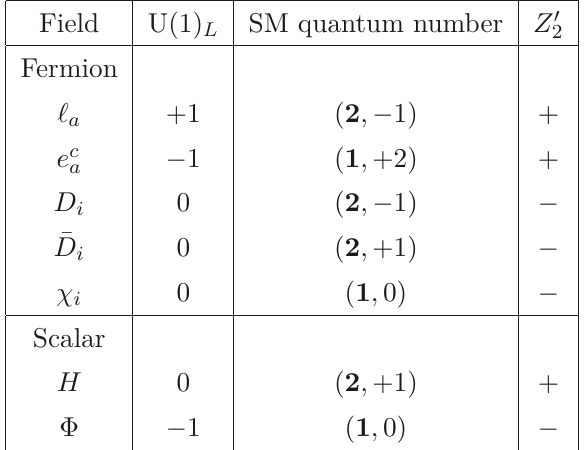
Table 1 . Particle content of the model responsible for one loop neutrino mass and dark matter. D i , ¯ D i and χ i are new fermionic fields as stated in the text. H is the SM Higgs doublet. The subscript a goes over lepton flavors and i goes over D flavors with a, i = 1 , 2 , 3. The lepton number of the different fields under U(1) L are shown in the second column. The SM SU(2) L numbers are in the third column. The Z ′ 2 quantum numbers in the table are guaranteed by the U(1) L symmetry. The SU(3) c group has been suppressed and all fields shown are color singlets. We have also omitted the quark